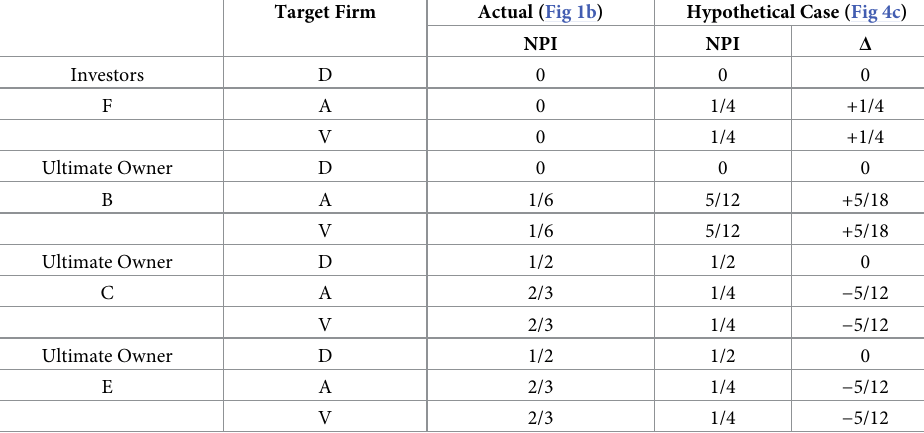
Table 6. Individual NPI values for ultimate owners B and C as well as investor(s) E